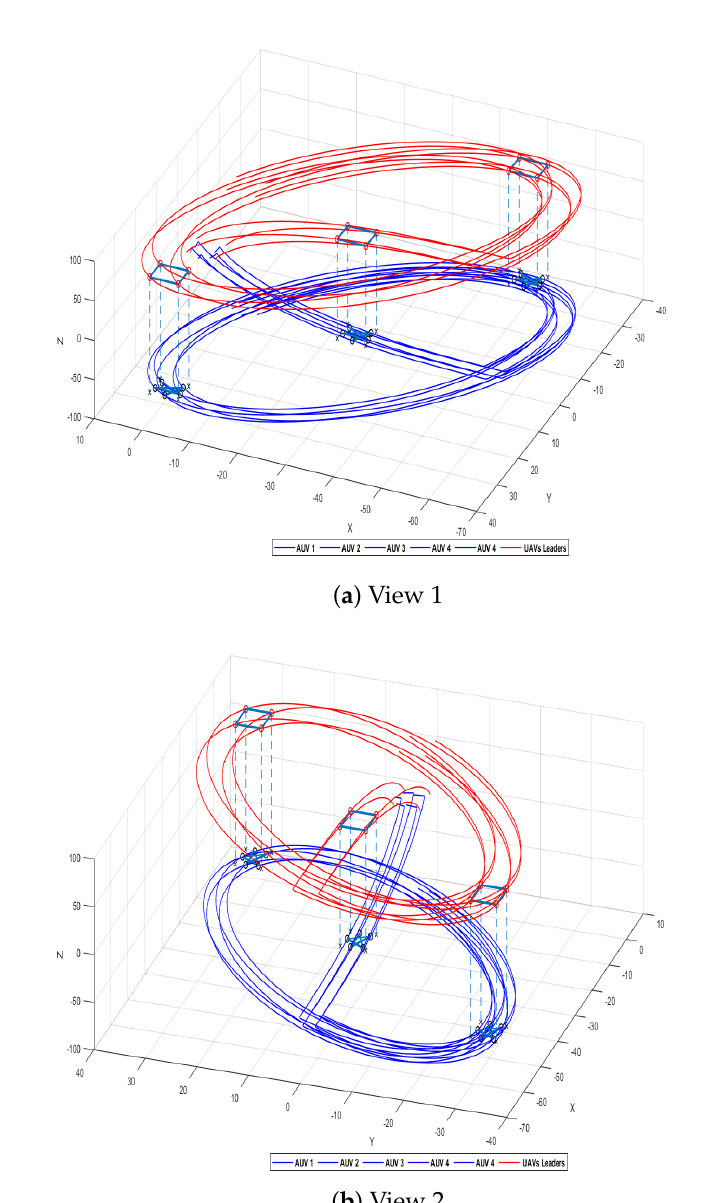
Figure 10. The containment control of five AUVs in star formation within their four UAVs leaders in square formation without disturbance and uncertainty in 3D